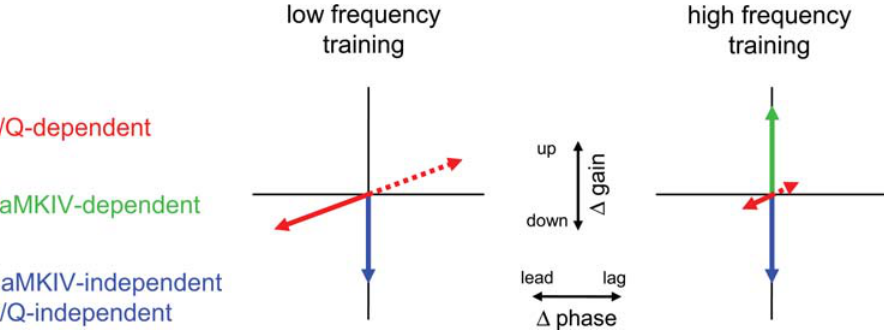
Figure 5. Working model of the multiple, molecularly-distinct components of motor learning in the VOR. The ordinate indicates changes in VOR gain and the abscissa indicates changes in VOR phase. A P/Q-dependent component of learning supports gain decreases linked with phase leads or gain increases linked with phase lags (red arrows). A CaMKIV-dependent component supports gain increases (green arrow). A CaMKIV- and P/Q-independent component supports gain decreases (blue arrows). The CaMKIV-dependent component (green arrows) is recruited more effectively by high-frequency training stimuli, whereas the P/Q-dependent component (red arrows) is recruited more effectively by low-frequency training